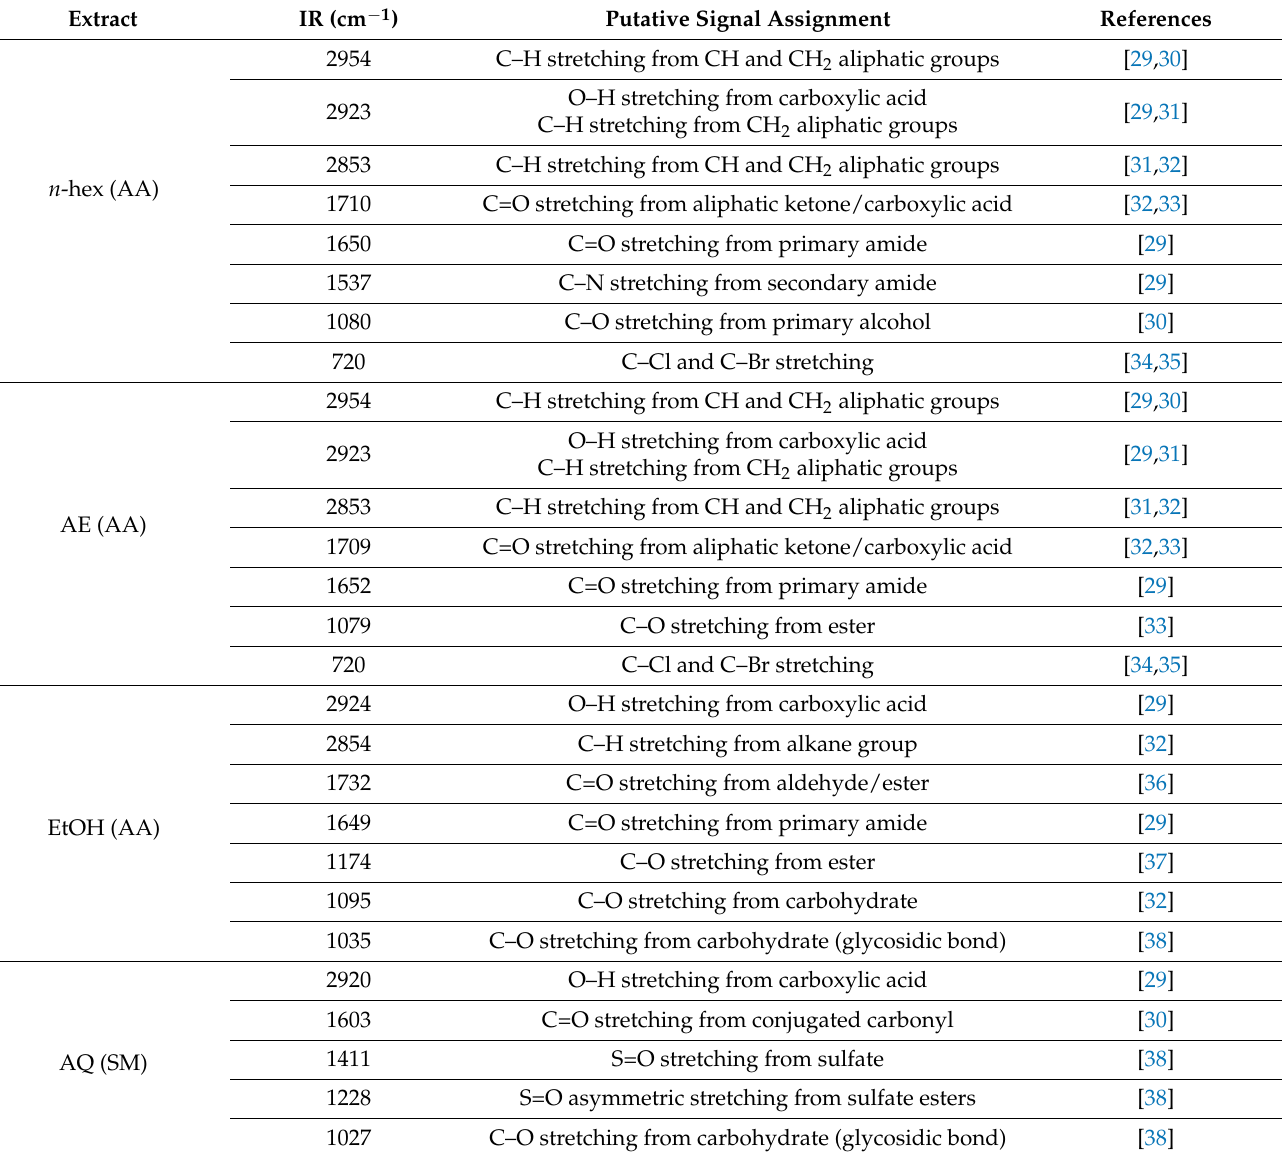
Table 6. FTIR-ATR spectroscopic analyses of the n -hexane ( n -hex), ethyl acetate (EA), and ethanolic (EtOH) extracts of Asparagopsis armata (AA) and the aqueous extract (AQ) of Sargassum muticum (SM). Extract Putative Signal